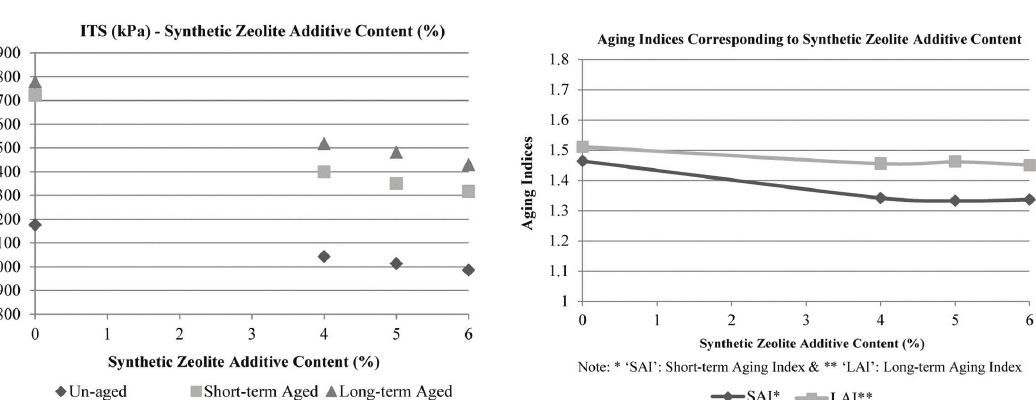
Figure 3. ITS results corresponding additive contents for natural zeolite modified mixtures.